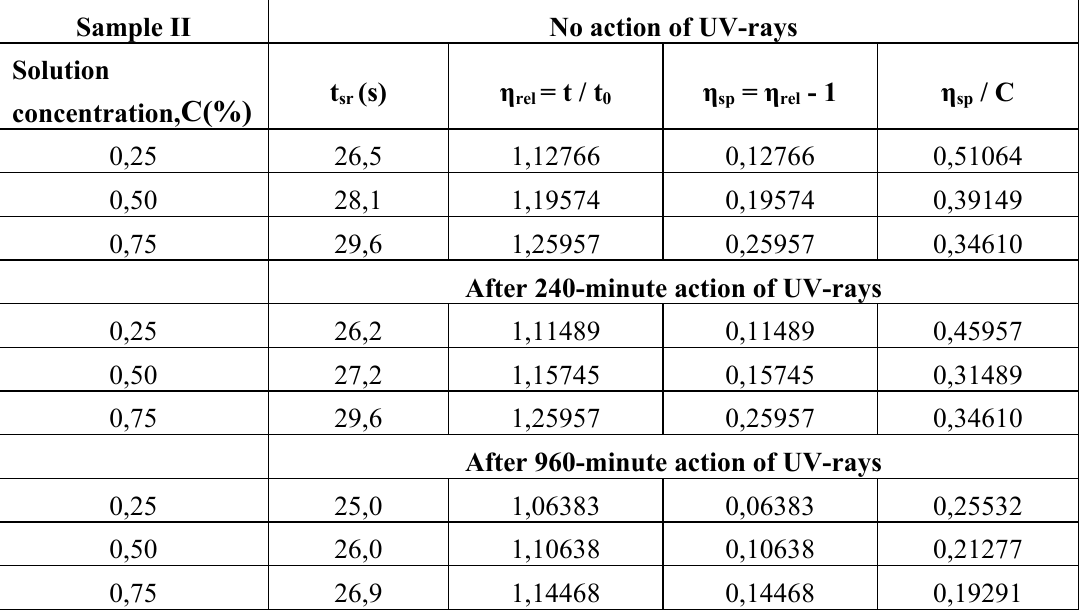
Table 5 . Viscosity values of nitrodope solution in acetone for sample II. Sample